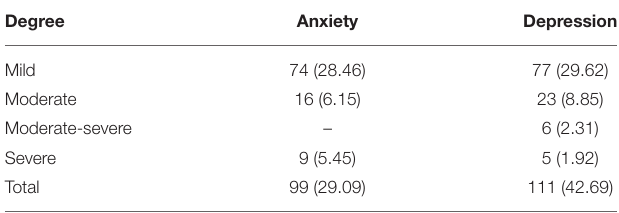
TABLE 1 | Prevalence of mood disorders among neonatal nurses